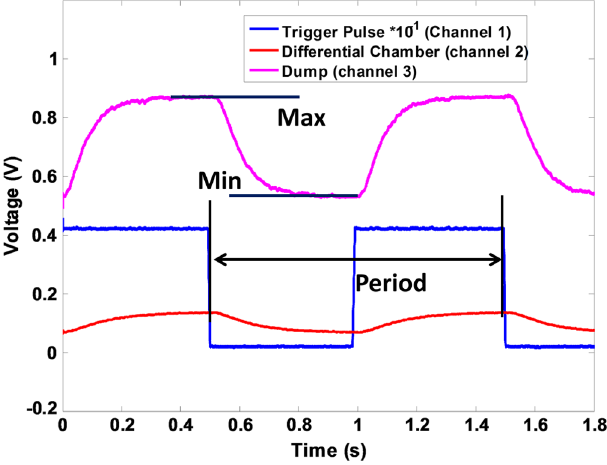
used.FIG. 12. Time structure of the pulsed valve and pressure response in the two chambers. The conversion factors between the displayed voltage (V) and the pressure in the chamber are 4 . 33 × 10 − 10 mbar = V for the differential chamber and 1 . 00 × 10 − 9 mbar = V for the dump